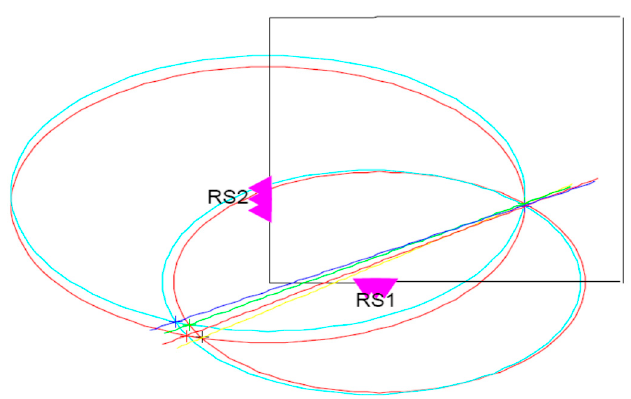
Figure 8. Combined intersections of ellipses: ( a ) E2 sets RS1 and E3 sets RS2 and ( b ) E2 sets RS1 and E4 sets RS2.